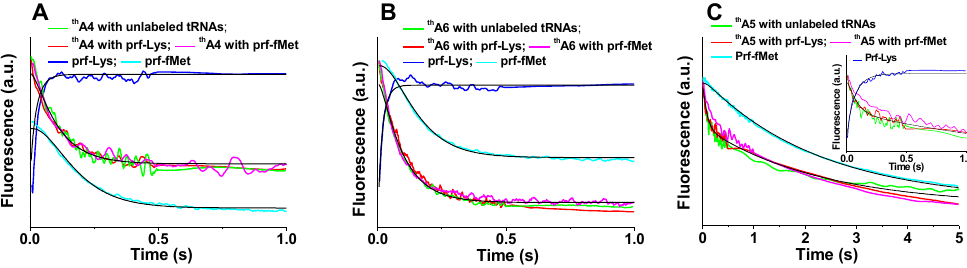
Figure 4. Kinetics of PRE complex formation. Ribosomes programmed with: ( A ) th A4; ( B ) th A6; ( C ) th A5. Fluorescence changes on rapid mixing of 70SICs (0.1 μ M) With Lys-tRNA Lys (0.4 μ M). Rates of th A fluorescence change were virtually identical using either unlabeled fMet-tRNA fMet and unlabeled aa-tRNA (green), unlabeled fMet-tRNA fMet and Lys-tRNA Lys (prf) (red), or fMet-tRNA fMet (prf) and unlabeled Lys-tRNA Lys (purple). Also shown are rates of fluorescence changes of Lys-tRNA Lys (prf) (dark blue) and of fMet-tRNA fMet (prf) (cyan). The inset in ( C ) shows an expanded time scale, making clear biphasic nature of th A5 fluorescence change. Solid black lines are fitted to Scheme 1, using rate constants provided in Table 2.